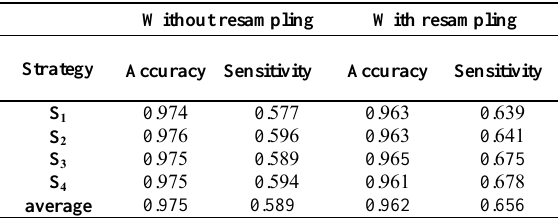
Table 7. Results of proposed methodology (cost-sensitive learning).